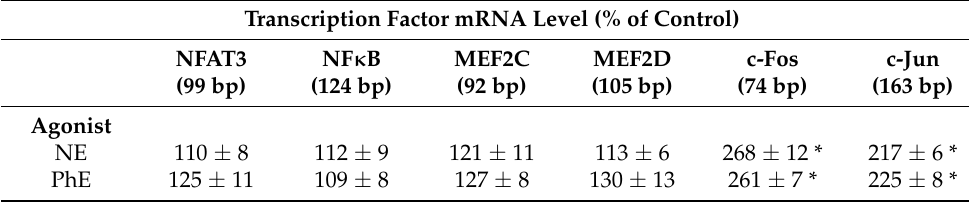
Table 1. Specific alterations in transcription factor gene expression in cardiomyocytes treated with norepinephrine and phenylephrine. Transcription Factor mRNA Level (% of Control)